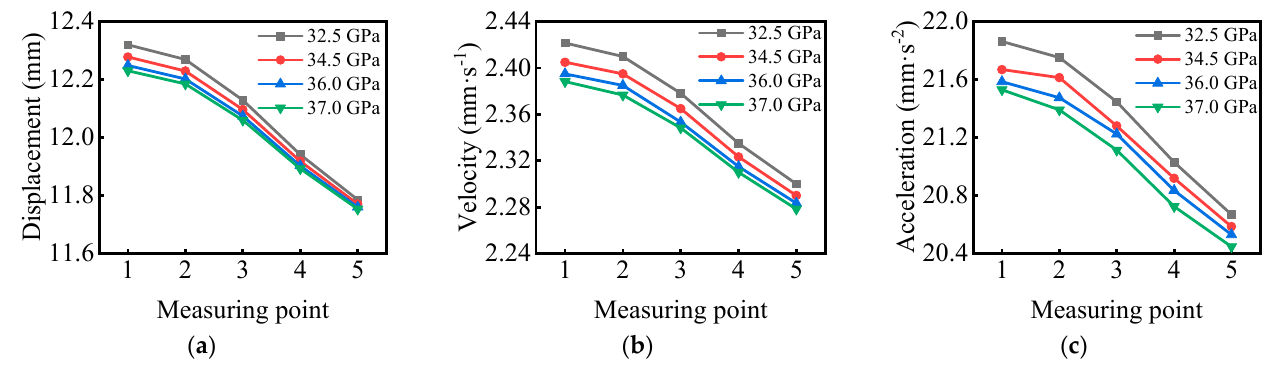
Figure 15. Peak value variation rule of different measuring points when the elastic modulus of concrete changes ( a ) displacement, ( b ) velocity, and ( c ) acceleration. Table 3. Results of peak displacement, velocity, and acceleration at the mid − span measuring point when the elastic modulus of concrete changes.